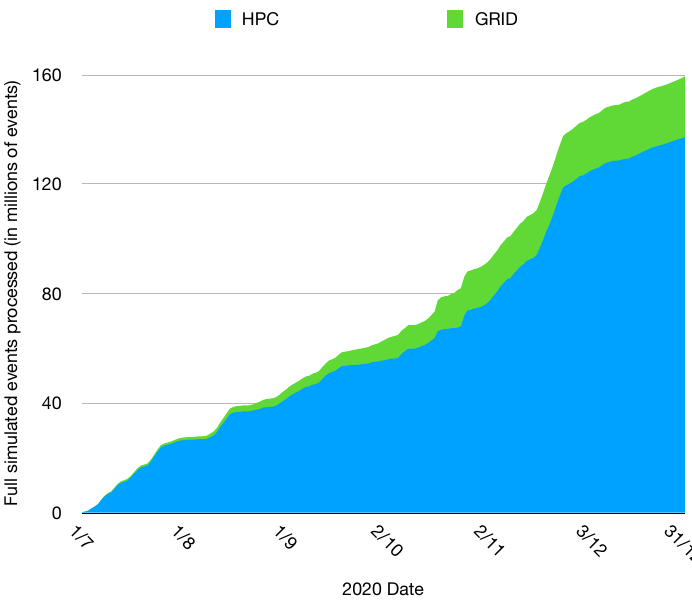
Figure 3. Time evolution of the accumulative number of full simulated events processed by GRID resources (green) and MareNostrum 4 HPC (blue) since the start of the agreement between Spanish Ministry of Science and the BSC in July